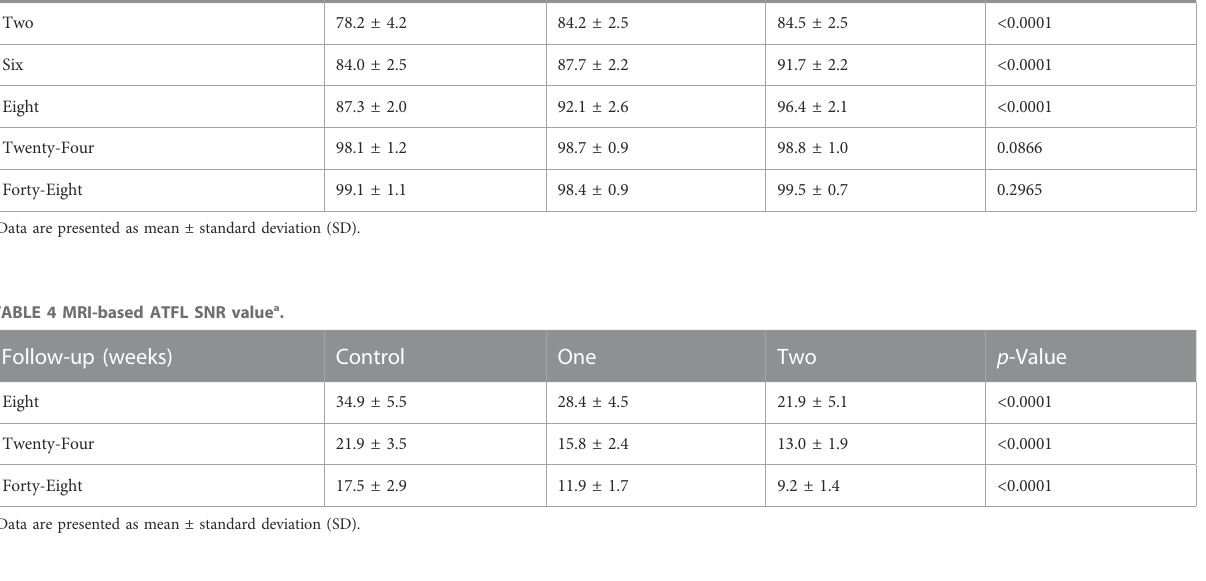
TABLE 3 Clinical results of the American orthopedic foot and ankle score (AOFAS) ankle-hindfoot scale a . Follow-up (weeks)